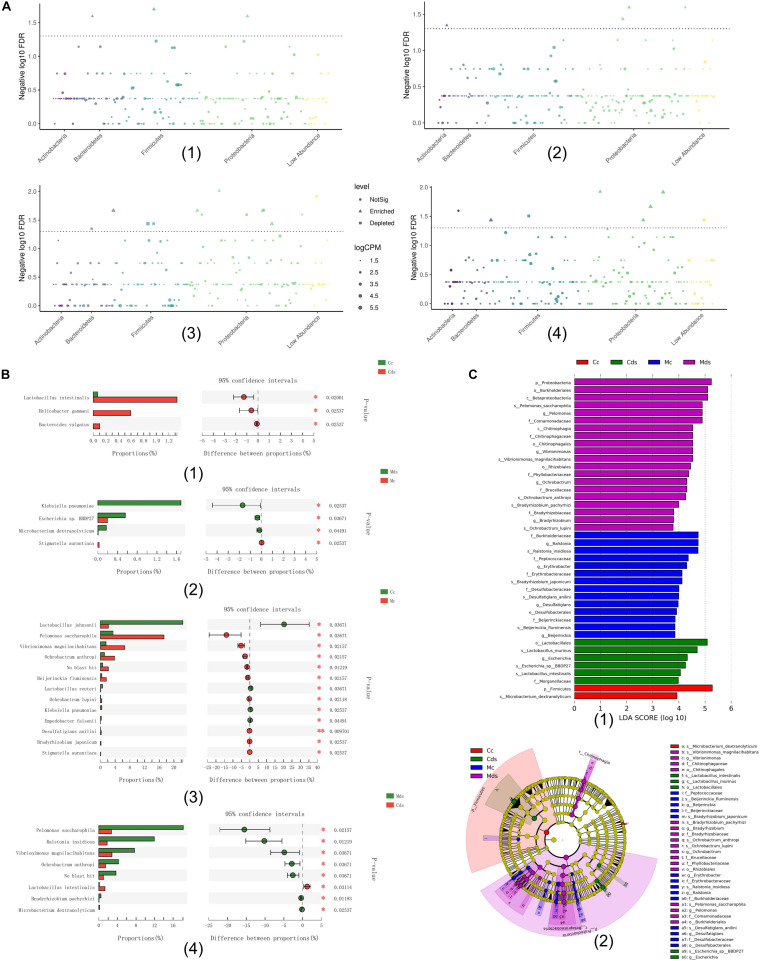
The key bacteria associated with repeated stress-related diarrhea in the intestinal contents and mucosa were identified. (A) Classification and significance of target taxonomic bacterial species at the phylum level; the element represents each bacterial species, the element size represents the relative abundance, and the element color represents the taxon level. (1) Comparison of intestinal content taxonomic bacterial species between repeated stress-related diarrhea mice and normal mice; (2) comparison of intestinal mucosa taxonomic bacterial species between repeated stress-related diarrhea mice and normal mice; (3) comparison of taxonomic bacterial species between intestinal contents and intestinal mucosa in control mice; (4) comparison of taxonomic bacterial species between intestinal contents and intestinal mucosa in repeated stress-related diarrhea mice. (B) Bacterial relative abundance significantly changed in the Wilcoxon rank sum test with P < 0.05. (C) (1) Cladogram generated from the LEfSe analysis indicating the phylogenetic distribution from phylum to species of the microbiota. (2) Histogram of LDA scores to identify differentially abundant bacterial species (LDA score ≥ 2, P < 0.05). *P < 0.05, **P < 0.01. Cc, intestinal contents in control mice; Cds, intestinal contents in repeated stress-related diarrhea mice; Mc, intestinal mucosa in control mice; Mds, intestinal mucosa in repeated stress-related diarrhea mice.